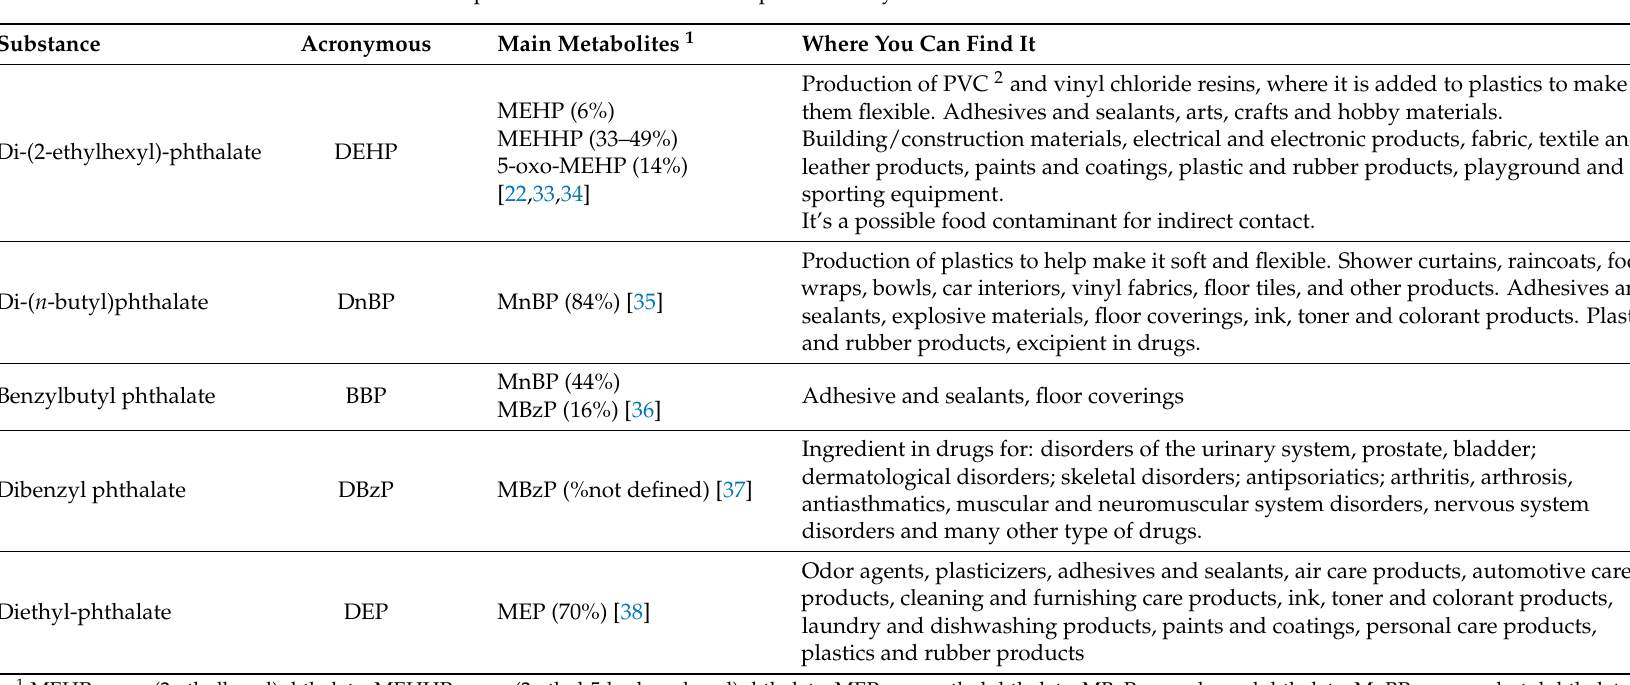
Table 2. List of the phthalates considered in the present study with details on their main metabolites and